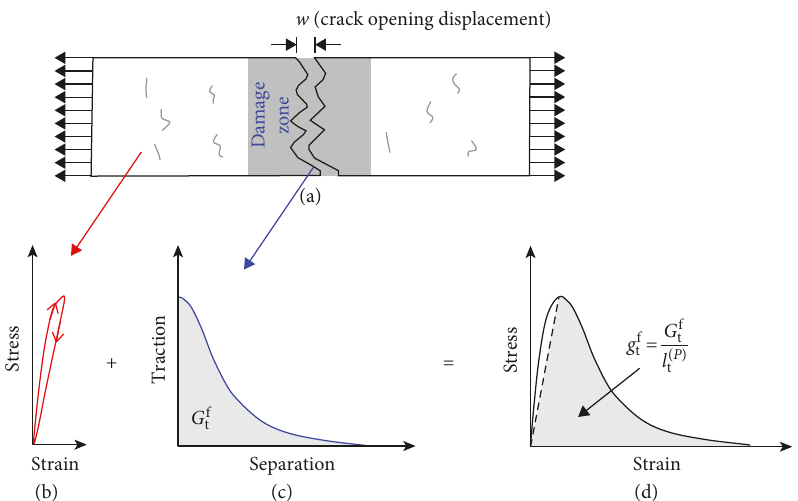
Figure 2: Damage zone and fracture energy regularization: (a) damage zone in the concrete specimen under tensile loading; (b) stress-strain response outside the damage zone; (c) traction-separation law in the damage zone; (d) general stress-strain relation for the concrete